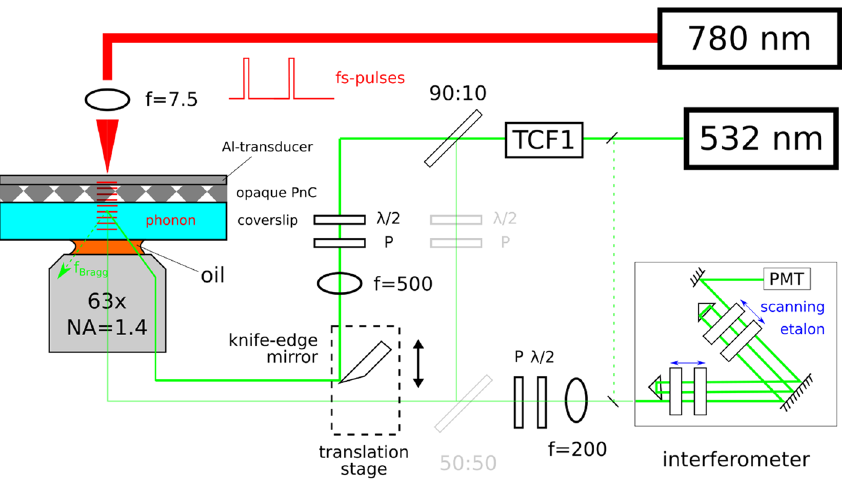
Figure 1. Setup for hybrid pump-probe experiments on a non-transparent phononic crystal (PnC), where the probe is a narrow-linewidth continuous-wave laser (“532 nm”) and the pump a femtosecond oscillator (“780 nm”). Broadband longitudinal phonons are injected into the PnC (diamond pattern) by the pump beam (thick red line), which is focused by an aspheric lens (f = 7.5 mm) to a micrometer-sized spot on an aluminum (Al) transducer film. Propagating into the coverslip, they form a moving diffraction grating by which the probe beam is scattered and frequency-shifted according to its angle of incidence on the grating. Normal incidence (thin green beam path) is always possible 48 but lower scattering angles are achieved through use of a high numerical aperture oil-immersion objective (“63×, NA = 1.4”). Here, frequency is controlled by offsetting the focused (f = 500 mm) probe beam (thick green beam path) from the center of the objective entrance pupil by means of a knife-edge mirror on a translation stage. Polarizers (“P”) and half-waveplates (“λ/2”) configure the beampath for longitudinal phonon analysis, while a mode-cleanup filter (“TCF1”) suppresses out-of-band laser noise. Finally, scattered probe light is analyzed by means of a tandem Fabry–Perot